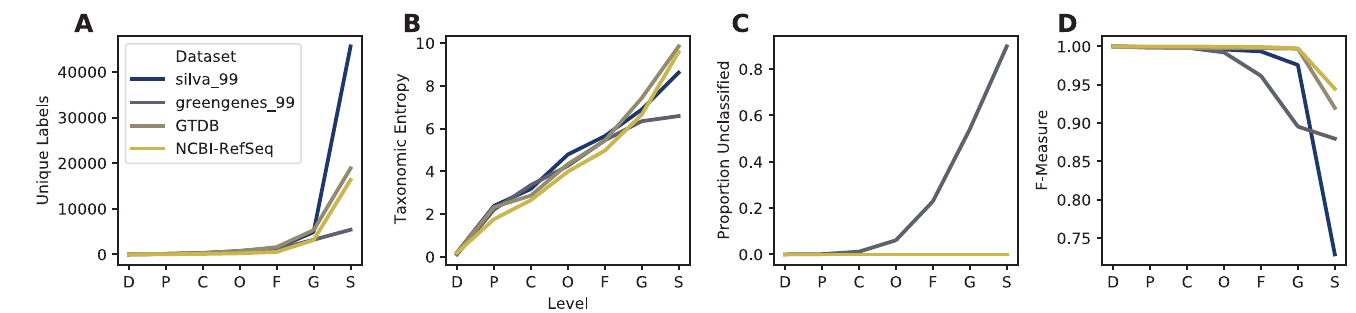
Fig 3. Comparison of taxonomic information and simulated classification accuracy from SILVA, Greengenes, GTDB, and NCBI-RefSeq 16S rRNA gene databases. A, Number of unique taxonomic labels; B, Taxonomic entropy; C, proportion of unclassified taxa at each rank; D, optimal classification accuracy (as F-Measure) without cross-validation (simulating best possible classification accuracy when the true label is known but classification accuracy may be confounded by other similar hits in the database). Cross-validation was not used because two of the databases (GTDB and NCBI-RefSeq) lack replicate species. Rank labels on x-axis: D = domain, P = phylum, C = class, O = order, F = family, G = genus, S = species.